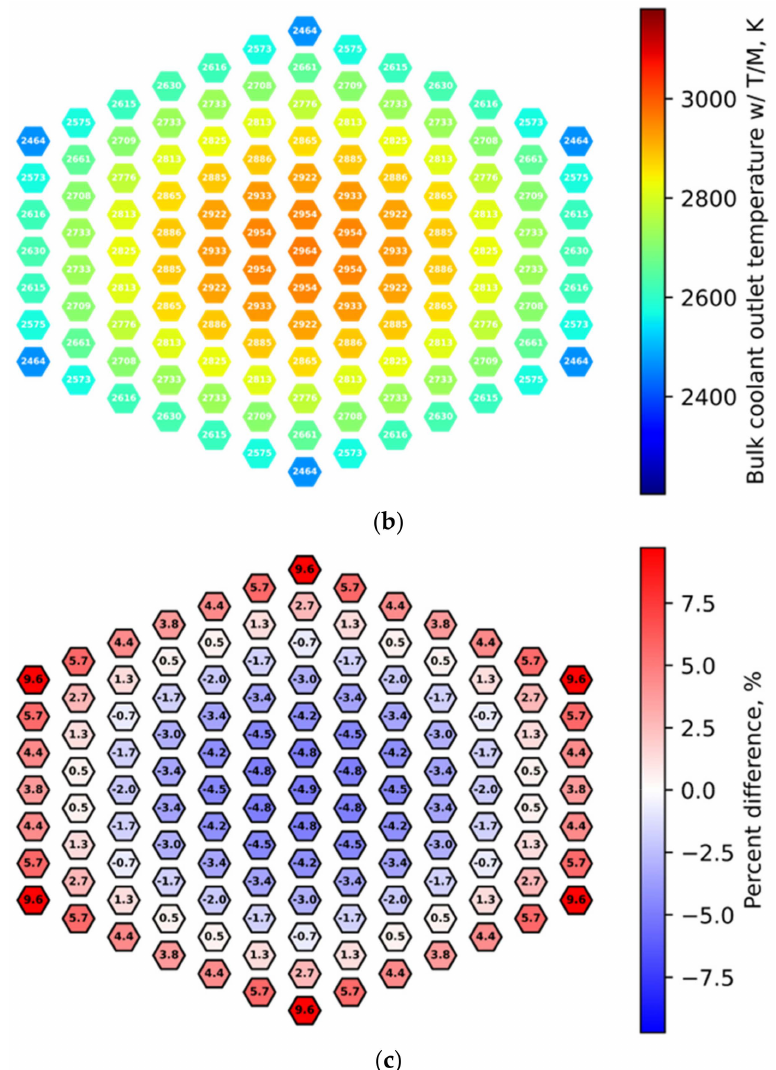
Figure 12. Comparison of outlet bulk coolant temperature ( a ) w/o T/M feedback; ( b ) w/ T/M feedback; ( c ) percent